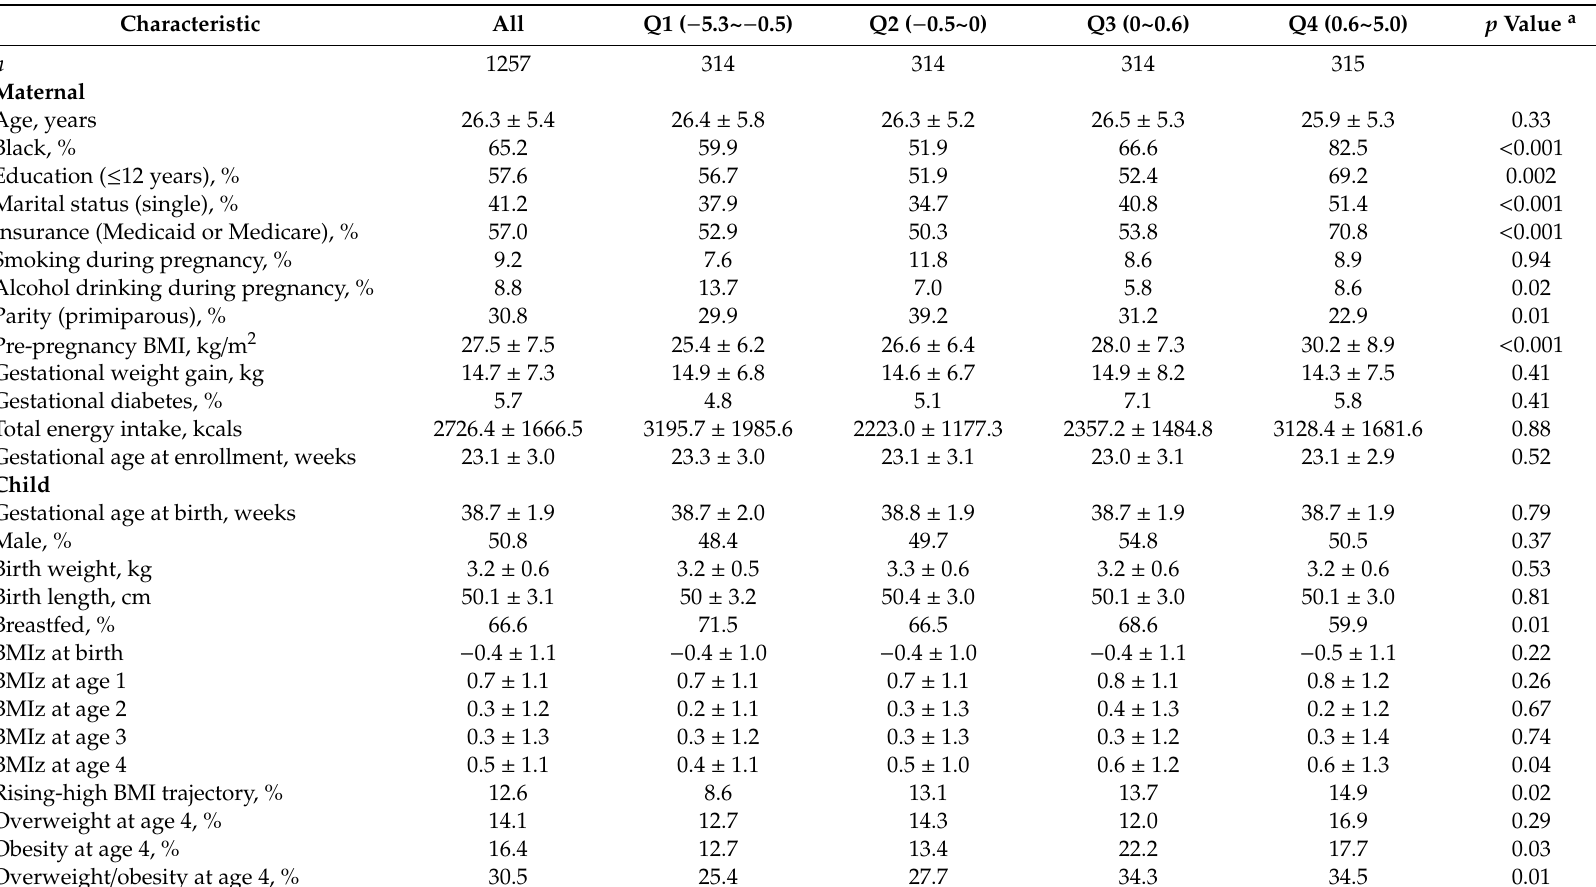
Table 2. Characteristics of the CANDLE mothers and children overall and according to quartiles of the fast food pattern score.